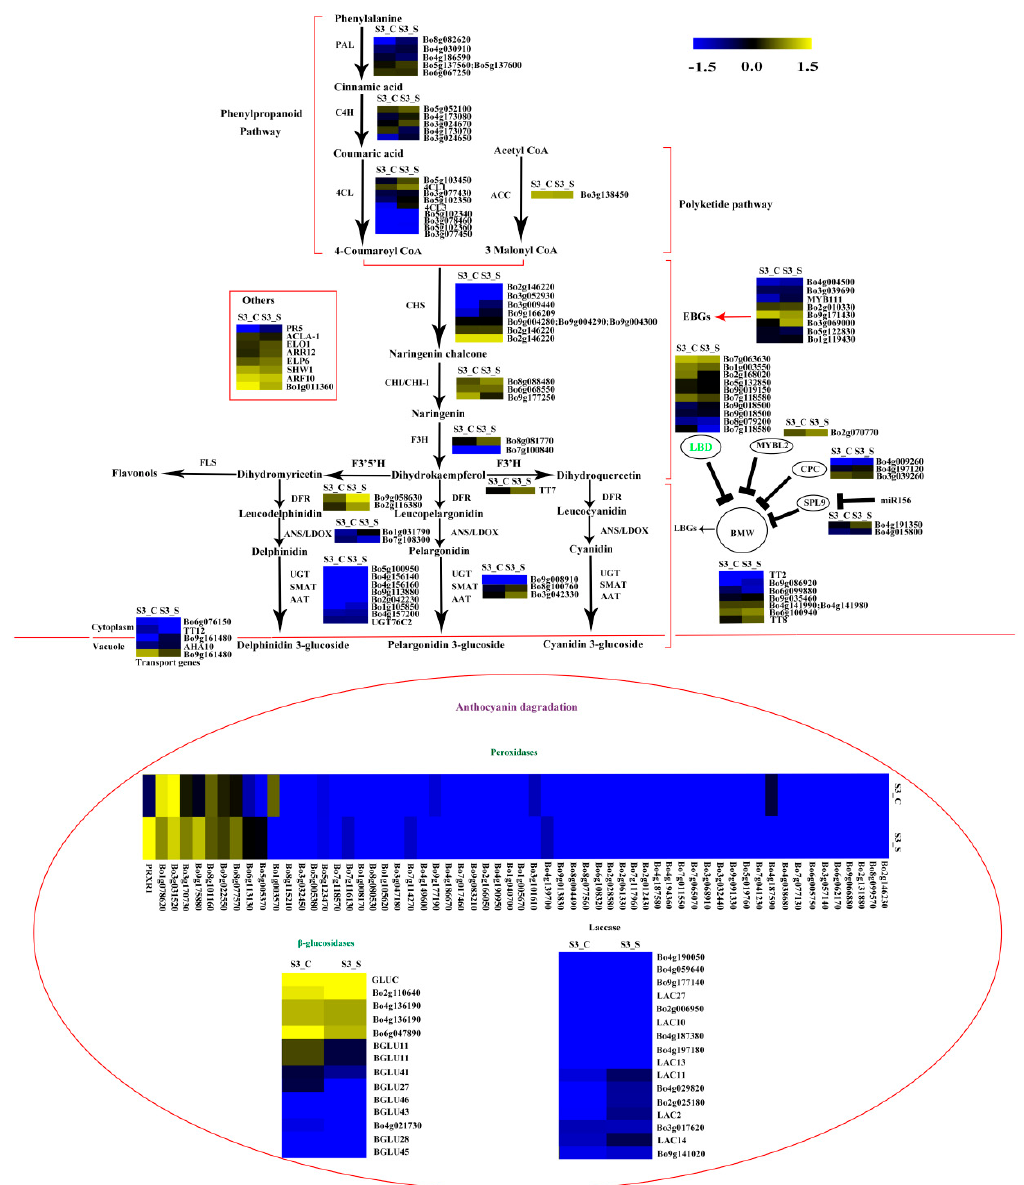
Figure 9. Expression pattern of the genes involved in anthocyanin biosynthesis and anthocyanin degradation in S3_S vs. S3_C. Enzyme names in green represent downregulated genes in S3_S vs. S3_C. The genes in the ovoid circle are the genes involved in anthocyanin degradation. The red parentheses represent the four pathways, the black and red arrows represent the positive regulation and black “ T ” represent negative regulation. The genes in the red box are the other genes involved in anthocyanin biosynthesis.